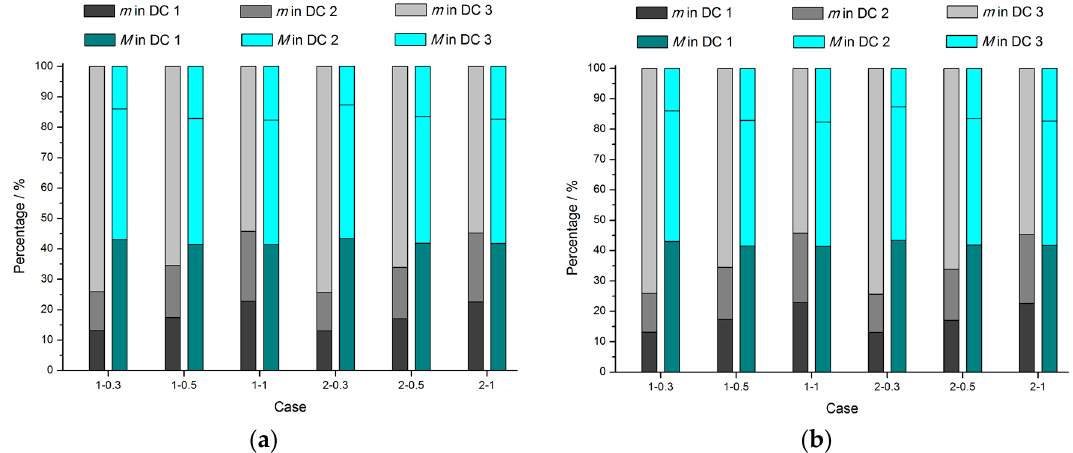
Figure 6. Mass flow rate and torque percentages in three DCs for two kinds of Tesla turbines at 30,000 r/min: ( a ) one-to-one Tesla turbine; and ( b ) one-to-many Tesla turbine.